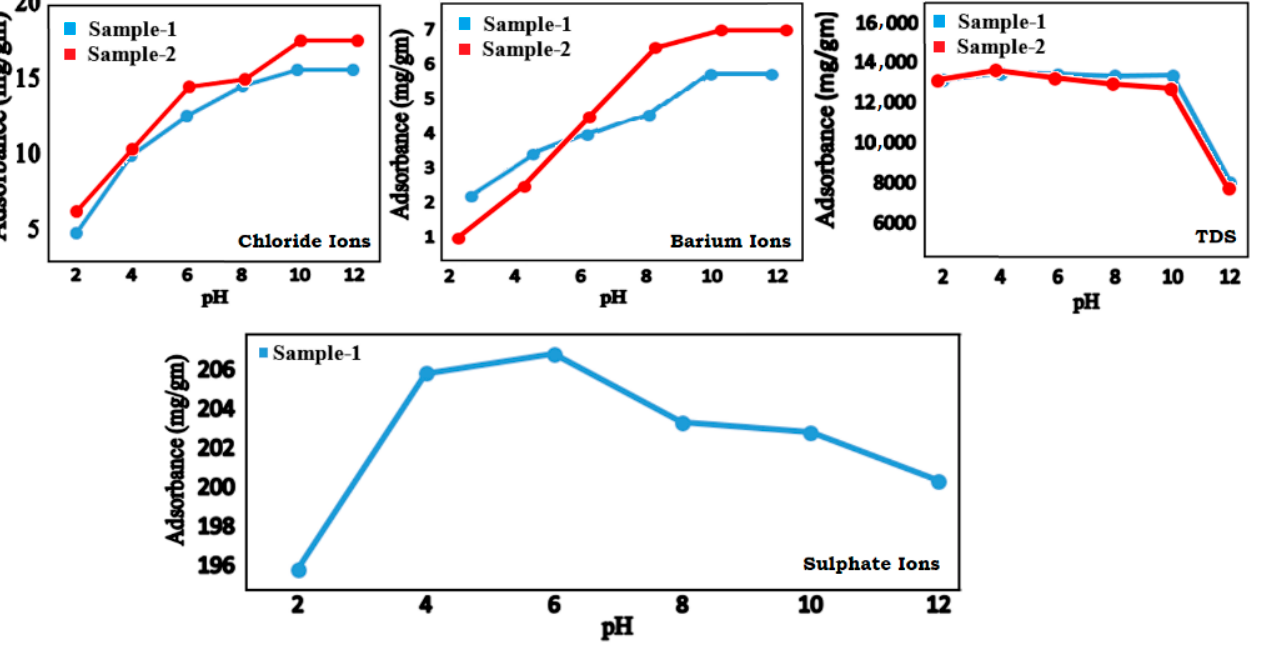
Figure 6. Adsorption concentrations (mg/gm) of chloride, TDS, barium and sulfate ions in sample 1 and 2 at different pH. Table 5. Adsorption concentration of chlorides ions in industrial wastewater samples at different pH.